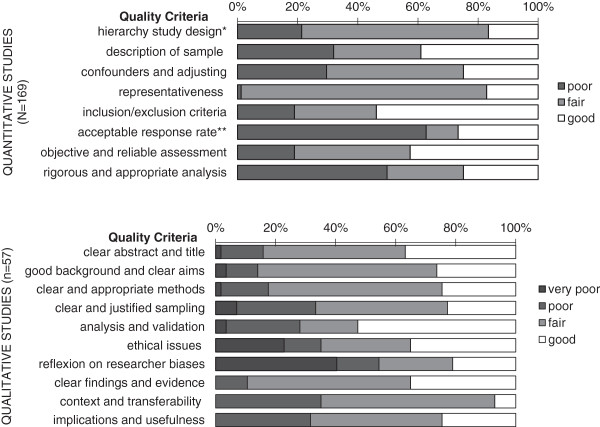
Quality assessment for studies using quantitative and qualitative methods. Footnote: Quantitative criteria applied to 169 studies (153 purely quantitative, 16 using both quantitative and qualitative methods). Qualitative criteria applied to 57 studies (41 purely qualitative and 16 using both quantitative and qualitative methods). * Rating for study design (poor = retrospective, fair = cross-sectional, good = prospective). ** Rating for acceptable response rate (poor <60% or unknown, fair 60%-69%, good ≥70%).